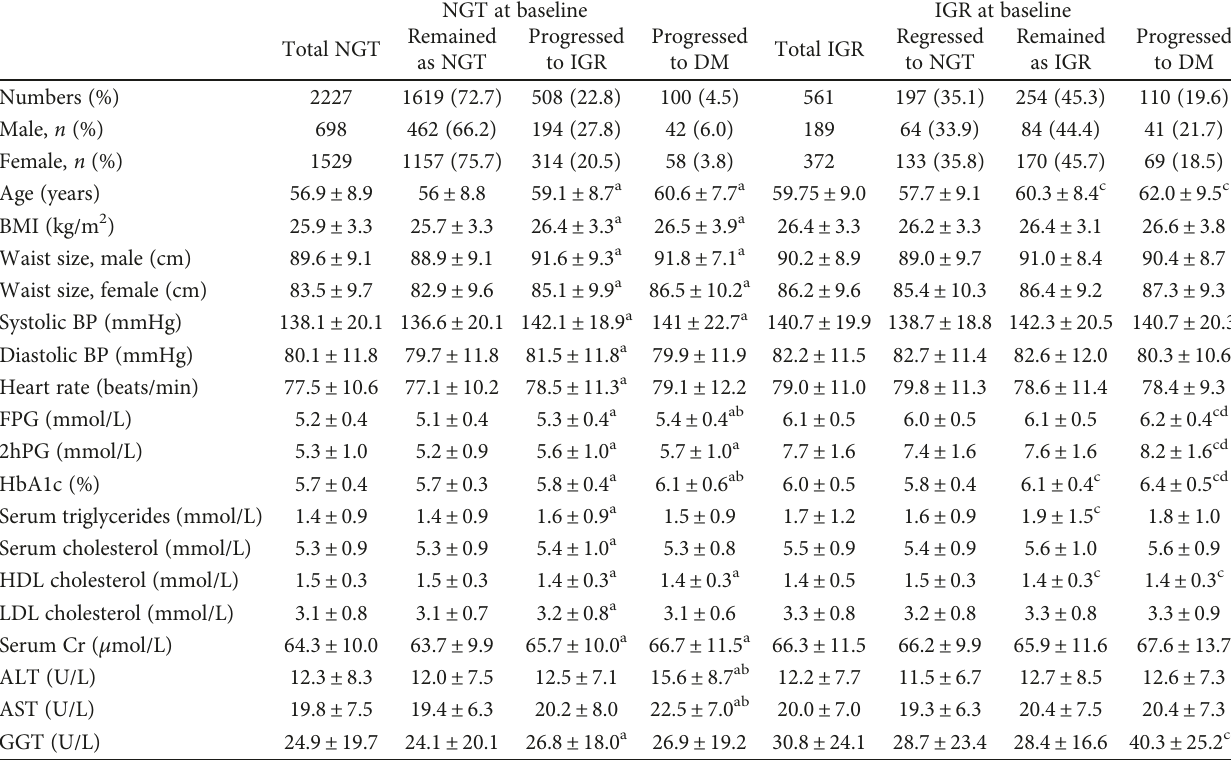
Table 1: Baseline characteristics of individuals with NGT and IGR based on their glycemic status at